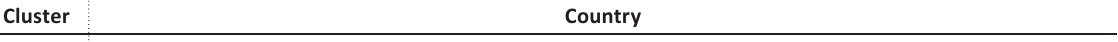
Table 2. Clustering of countries by level of socio-economic development in 2018